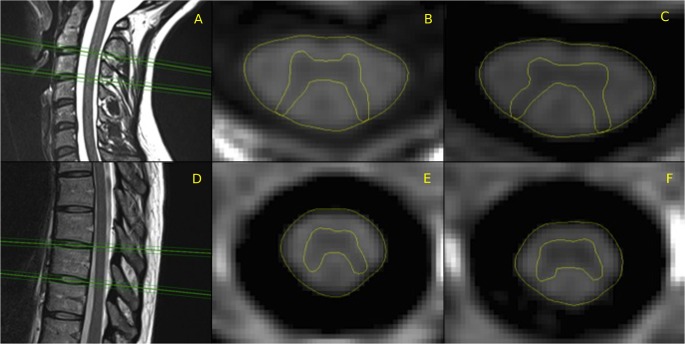
Example of acquisition and segmentation.Example of acquisition and total cross-sectional area (TCA) and gray matter (GM) segmentation on a representative healthy subject. Left: Sagittal images, positioning of 2D PSIR slices (A: cervical portion, D: thoracic portion). Right: segmentation on the phase-sensitive reconstructed images (B: C2-C3, C: C3-C4, E: T8-T9, F: T9-T10 disc levels).